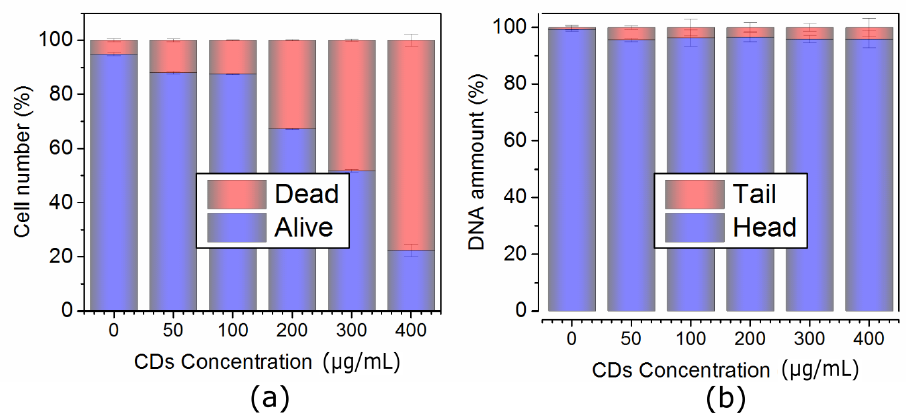
Figure 6. ( a ) Viability and ( b ) genotoxicity of L929 cells exposed to the concentration line of QCDs and incubated 24 h. Please note the following genotoxicity terms: “head” is intact DNA in nucleus, “tail” is damaged DNA migrated away from the nucleus; when the tail value is more than 10%, the dose is genotoxic.